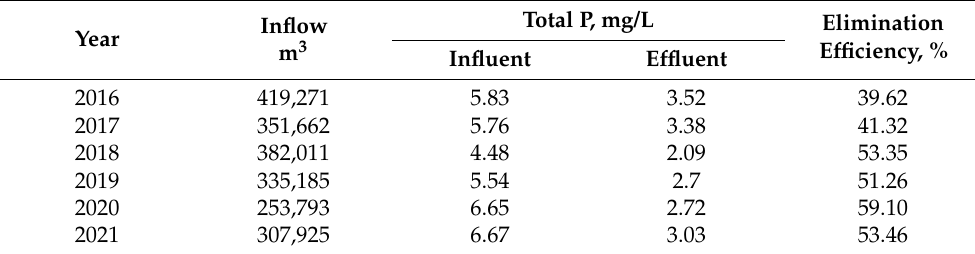
Table 4. Phosphorus removal after the use of FeCl 3 .